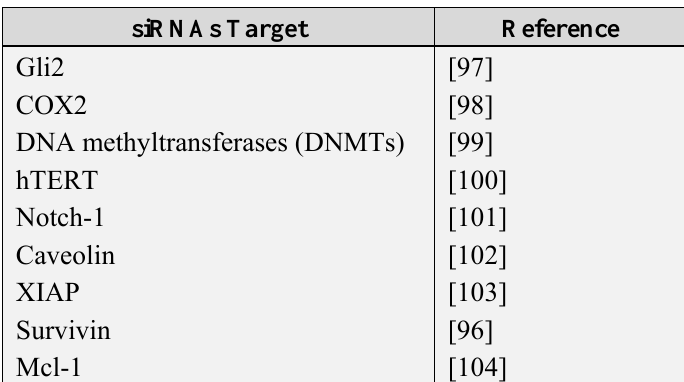
Table 4. siRNA studies to enhance TRAIL